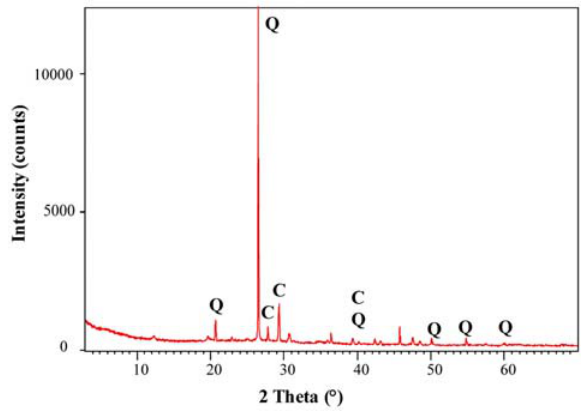
Figure 3 . X-ray diffraction of FS natural clay (Q: Quartz, C: Calcite)